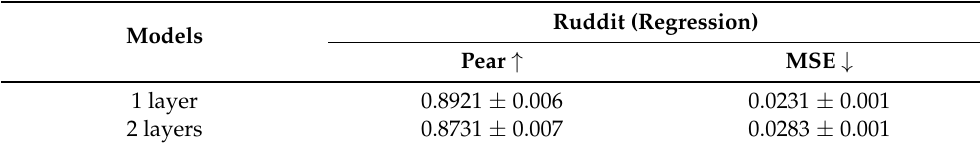
Table 4. Effect of number of extraction network